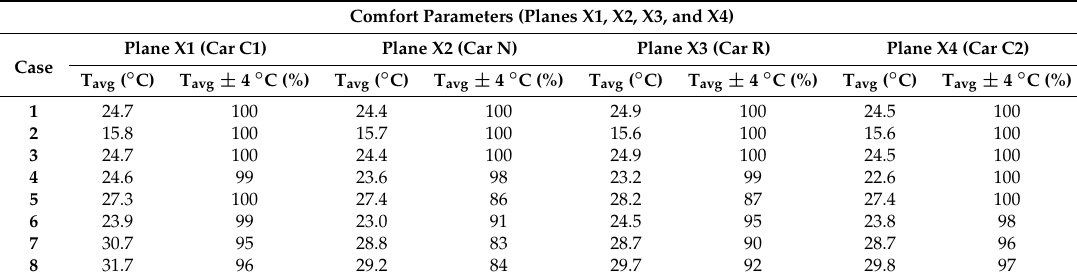
Table 5. Temperature parameters at vertical